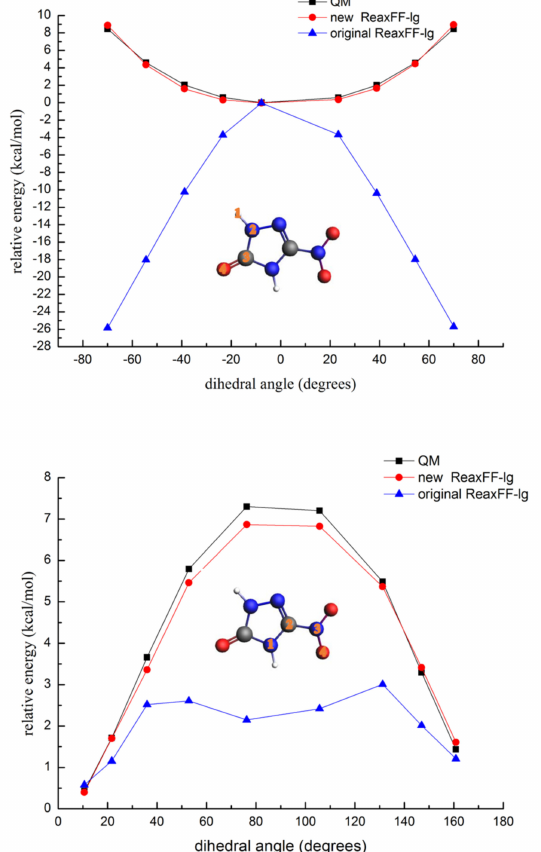
Figure 6. Rotational energy barriers for the H-C-N-O and N-C-N-O dihedral angles in NTO (gray— carbon atom; white—hydrogen atom; red—oxygen atom; blue—nitrogen